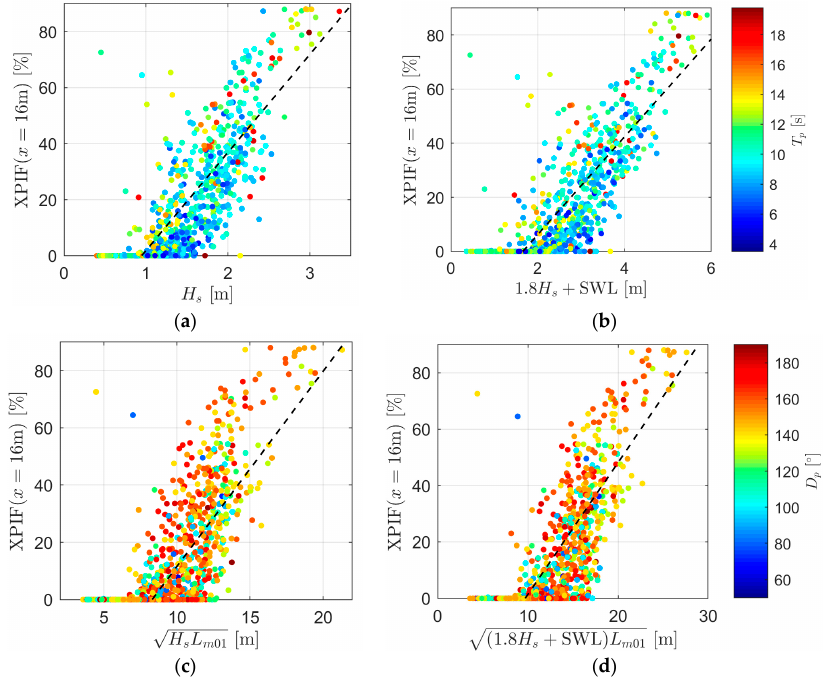
Figure 10. Comparison of inundation on the platform at the Figure Eight Pool location (XPIF at x = 16 m on transect N2, see Figure 2 for location) with: ( a ) significant wave height ( H s ); ( b ) 1.8 H s plus tidal still water level (1.8 H s + SWL); ( c ) square root of significant wave height times wavelength derived from the spectral mean wave period ( (cid:3493)(cid:1834) (cid:3046) (cid:1838) (cid:3040)(cid:2868)(cid:2869) ); and ( d ) (cid:3493)(1.8 (cid:1834) (cid:3046) + SWL)(cid:1838) (cid:3040)(cid:2868)(cid:2869) . The points in panels ( a , b ) are colored by peak wave period (see color bar in panel ( b )). The points in panels ( c , d ) are colored by peak wave direction (see color bar in panel ( d )). Linear regression lines calculated using data with XPIF ≥ 1% are show in each panel and correspond to: ( a ) XPIF = 35.0 (cid:1834) (cid:3046) − 33.1 , R 2 = 0.55; ( b ) XPIF = 18.1(1.8 (cid:1834) (cid:3046) + SWL) − 30.0 , R 2 = 0.57; ( c ) XPIF = 6.3(cid:3493)(cid:1834) (cid:3046) (cid:1838) (cid:3040)(cid:2868)(cid:2869) − 45.0 , R 2 = 0.48; ( d ) XPIF = 4.7 1.8 H s + SWL ) L m 01 − 45.4, R 2 = 0.51. All linear regression equations have p <